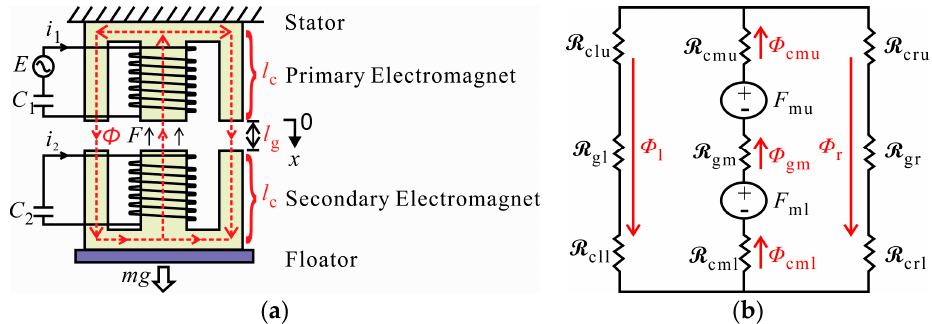
Figure 3. Schematic diagram of magnetic circuit: ( a ) basic model of the magnetic circuit; ( b ) equivalent magnetic circuit of the basic model.